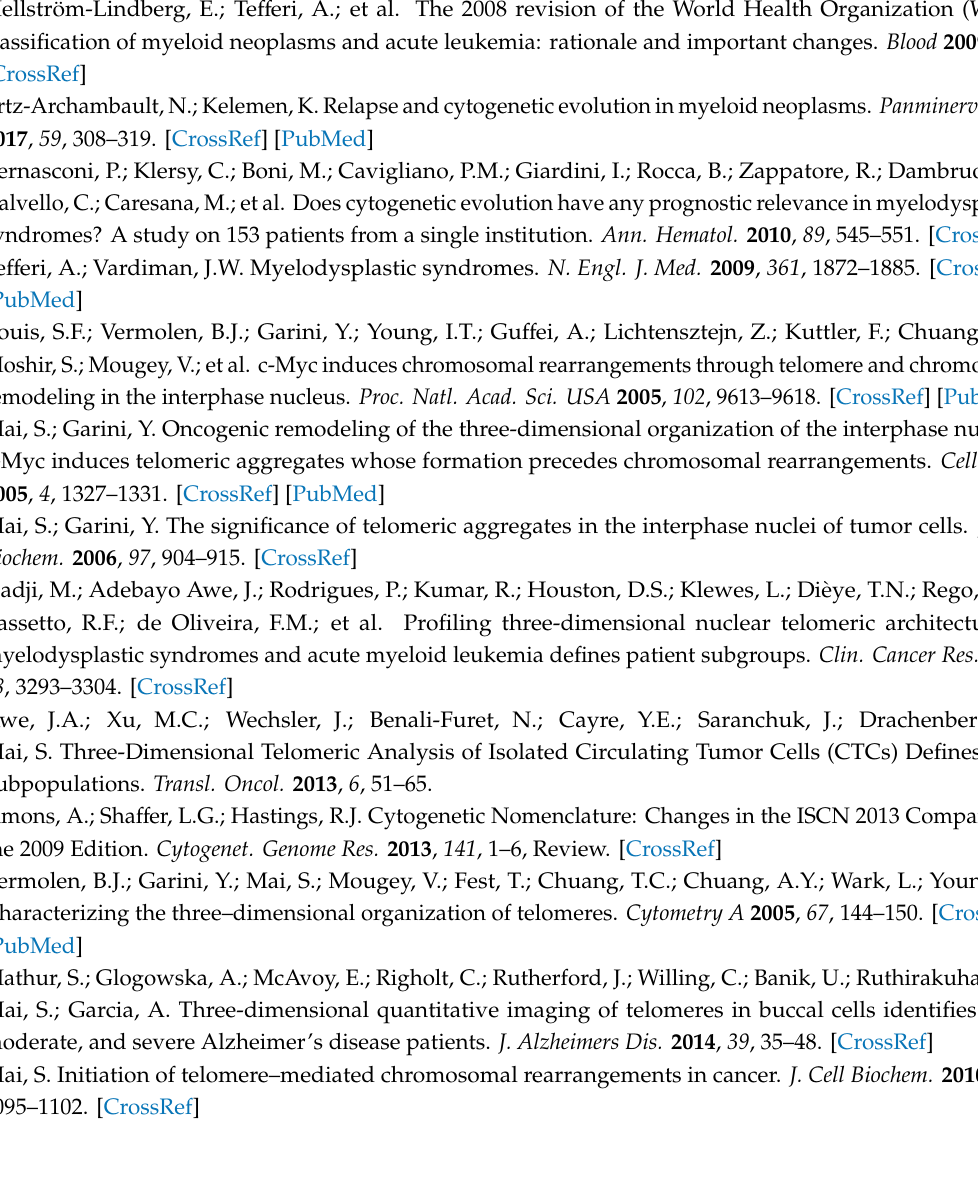
Table S1: Clinical characteristics of fifteen myelodysplastic syndrome patients with clonal cytogenetic evolution, Table S2: Statistical Analysis of Telomere Parameters in each time point for fifteen myelodysplastic syndrome